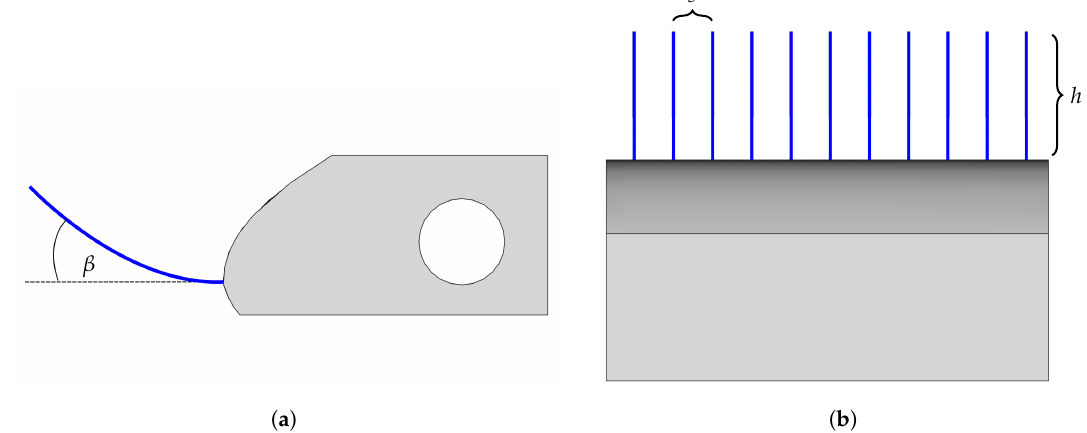
Figure 4. Schematic of the comb structures used in the present study, gray: leading edge insert, blue: teeth of the comb, ( a ) side view, ( b ) top view, detail.